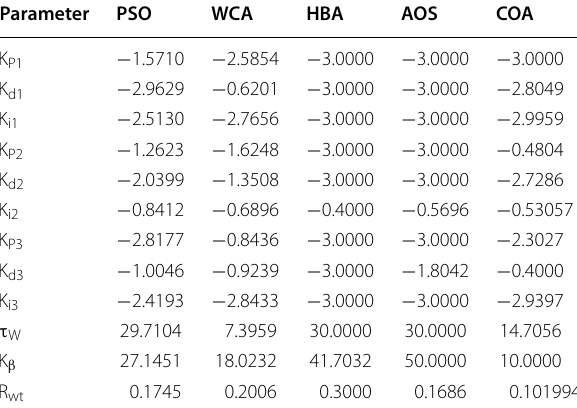
Table 2 Parameters of PID controllers